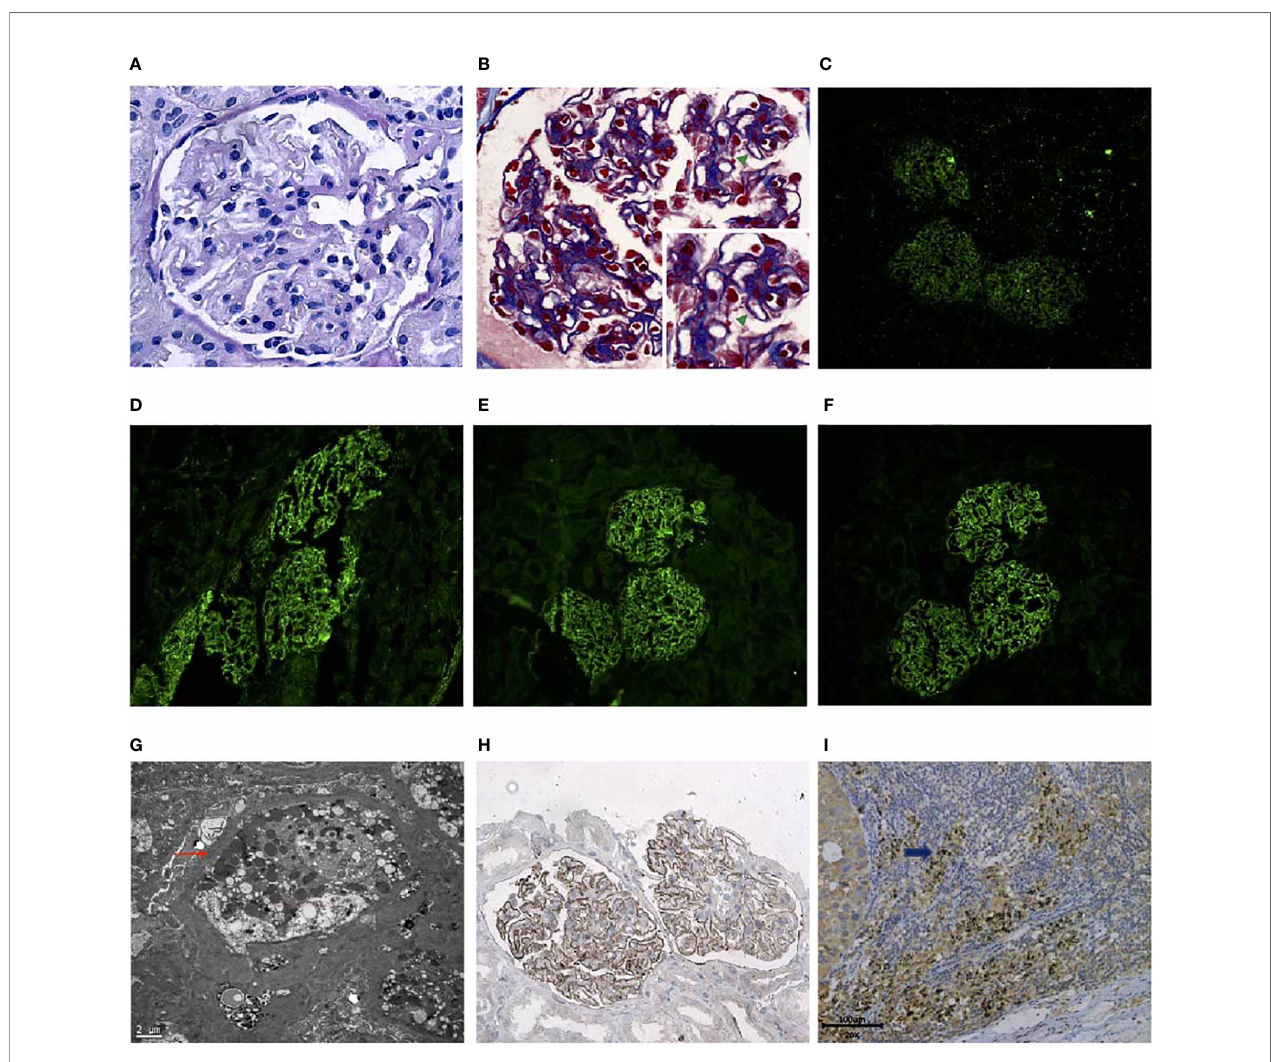
FIGURE 2 | Renal biopsy fi ndings showing a THSD7A-associated MN Renal histology specimens and baseline tumor tissue. (A) Periodic acid-Schiff (PAS) stain showing stiff glomeruli (Original magni fi cation,400×). (B) Masson trichrome stain showing subepithelially localized immune deposits (green arrow) (Original magni fi cation,400×). (C) Immuno fl uorescence of IgG deposition in the subepithelial area. (Original magni fi cation,200×). (D) Immuno fl uorescence of subepithelial IgG1 deposition. (Original magni fi cation,200×). (E) Immuno fl uorescence of subepithelial IgG2 deposition. (Original magni fi cation,200×). (F) Immuno fl uorescence of subepithelial IgG4 deposition. (Original magni fi cation,200×). (G) Electron microscopy showing discrete electron-dense subepithelial deposits (red arrow). (Original magni fi cation, 6000×). (H) Positive staining for thrombospondin type-1 domain-containing 7A (THSD7A) along the glomerular basement membrane. (Original magni fi cation×200). (I) The tumor cells of baseline metastases lymph node were positive for thrombospondin type-1 domain-containing 7A (THSD7A) by immunohistochemistry (blue